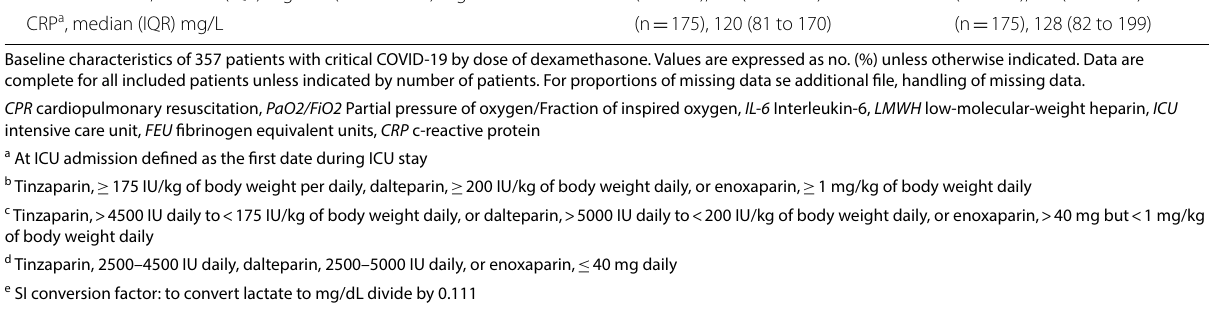
LMWH-dose (Additional file 2: Table S1). The adjusted HR for primary outcome for the 12 mg vs. 6 mg group